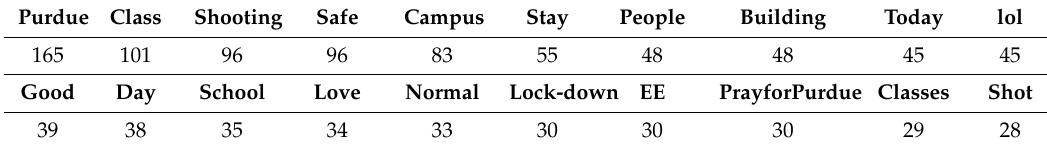
Table 1. Word frequency of the most significant cluster about the gunshot in West Lafayette, IN.